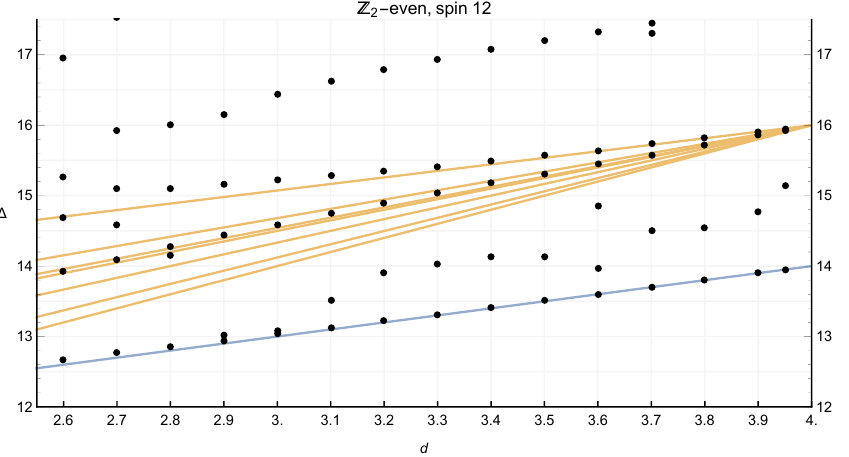
Figure 10 . Z 2 -even operators of spin